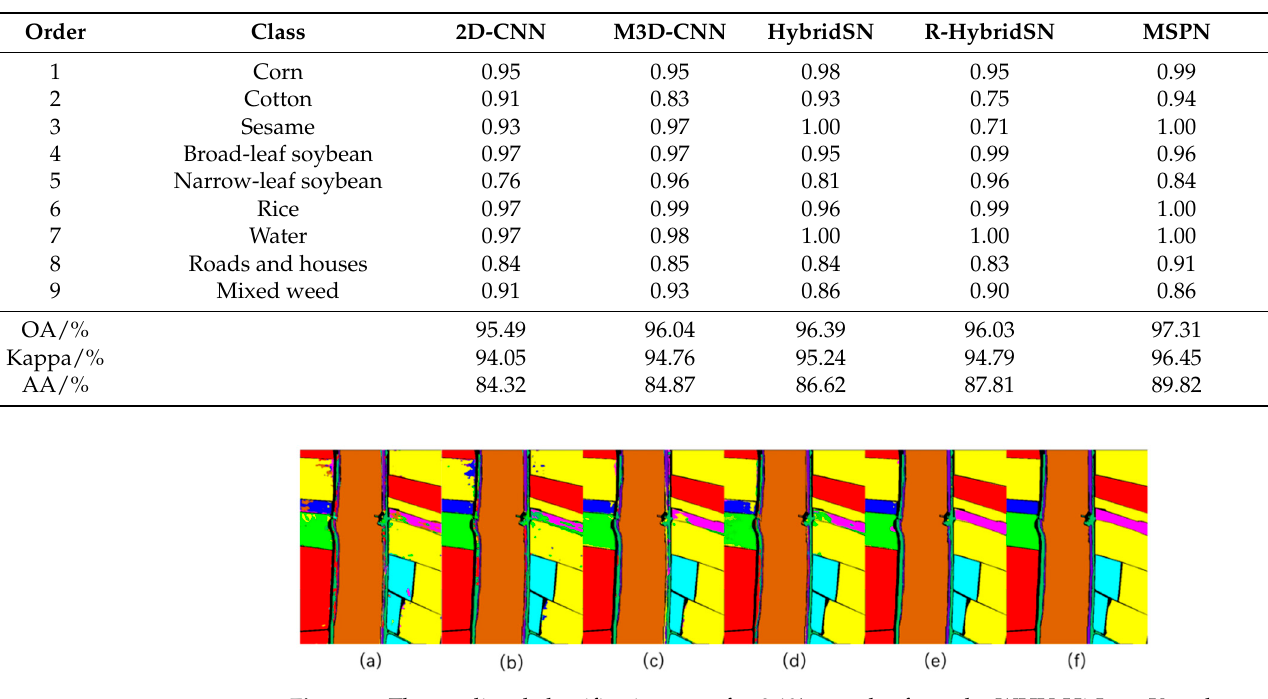
Table 6. Accuracy comparison of different methods for 0.1% samples from the WHU-Hi-LongKou dataset.